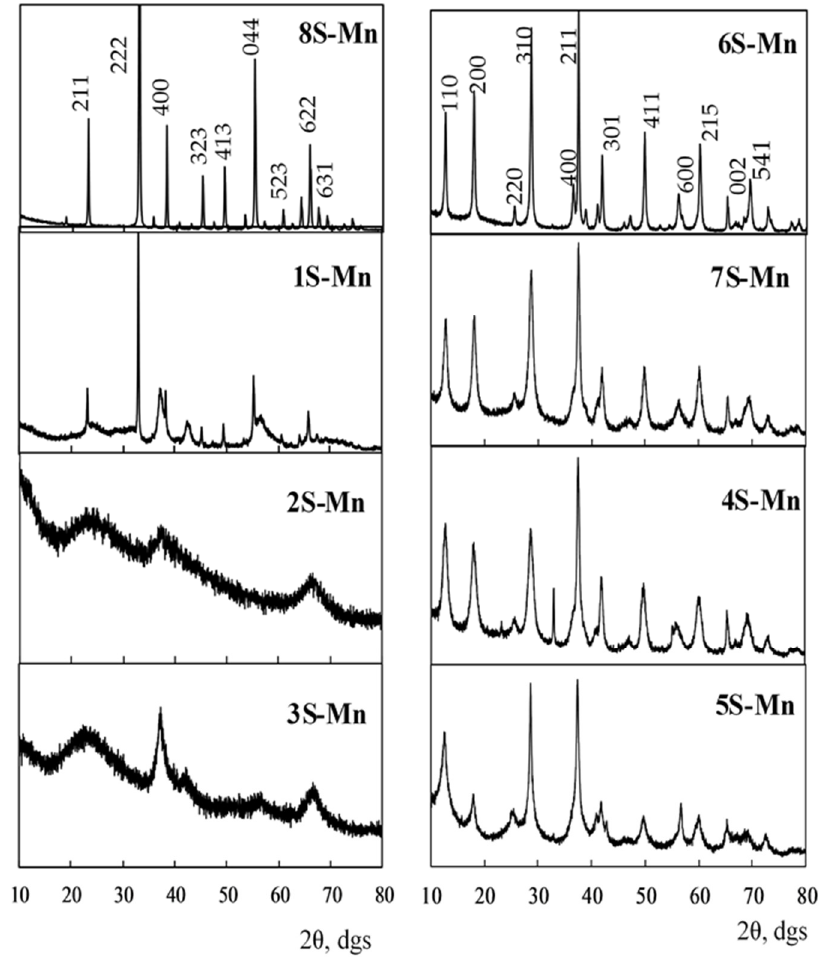
Figure 1. X-ray diffraction patterns of the manganese oxide samples under Figure 1. X‐ray diffraction patterns of the manganese oxide samples under study.